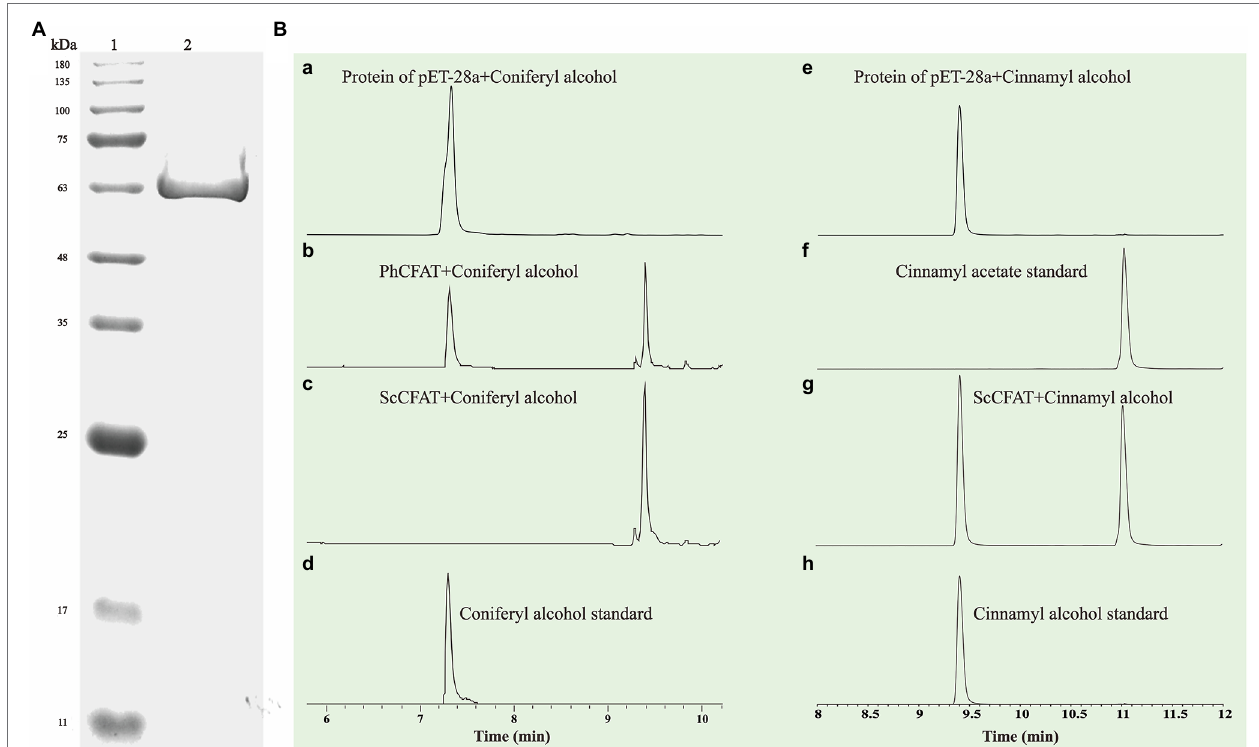
FIGURE 5 | (A) SDS-PAGE analysis of recombinant ScCFAT. ScCFAT was separated using 12% SDS-PAGE gel electrophoresis and protein bands were visualized after staining with Coomassie brilliant blue. Lane 1: protein marker; Lane 2: purified ScCFAT. (B) In vitro analyses of ScCFAT and PhCFAT activities. (a) UPLC analysis of compounds found in a reaction mixture containing protein of pET-28a, coniferyl alcohol, and acetyl-CoA after 15 min of incubation. (b) UPLC analysis of compounds found in a reaction mixture containing purified PhCFAT, coniferyl alcohol, and acetyl-CoA after 15 min of incubation. (c) UPLC analysis of compounds found in a reaction mixture containing purified ScCFAT, coniferyl alcohol, and acetyl-CoA after 15 min of incubation. (d) UPLC analysis of coniferyl alcohol standard. (e) UPLC analysis of compounds found in a reaction mixture containing protein of pET-28a, cinnamyl alcohol, and acetyl-CoA after 15 min of incubation. (f) UPLC analysis of cinnamyl acetate standard. (g) UPLC analysis of compounds found in a reaction mixture containing purified ScCFAT, cinnamyl alcohol, and acetyl-CoA after 15 min of incubation. (h) UPLC analysis of cinnamyl alcohol